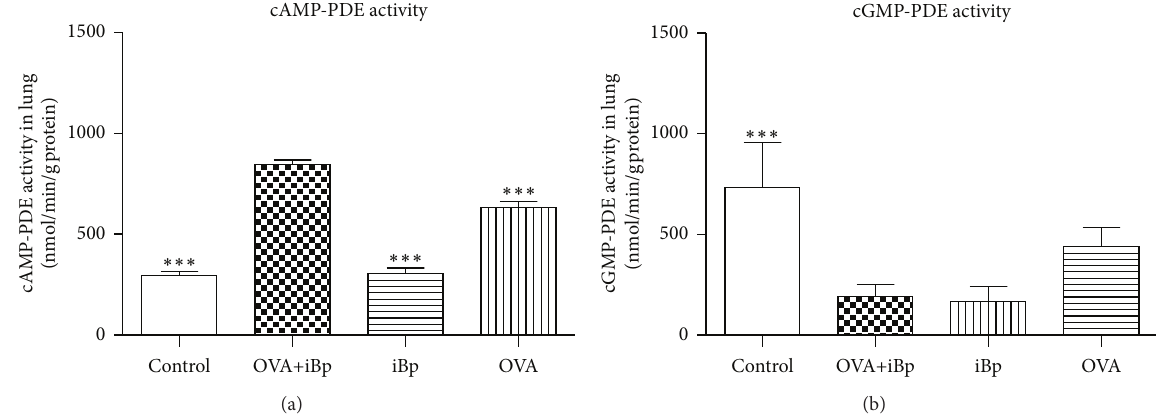
Figure 2: (a) Lung cAMP-PDE activity in normal ( 𝑛 = 8 ), OVA+iBp, iBp ( 𝑛 = 6 ), and OVA rats ( 𝑛 = 8 ); (b) lung cGMP-PDE activity in normal ( 𝑛 = 8 ), OVA+iBp, iBp ( 𝑛 = 6 ), and OVA rats ( 𝑛 = 8 ) (mean ± SEM; ∗ 𝑃 < 0.05 ; ∗∗ 𝑃 < 0.01 versus OVA+iBp; # 𝑃 < 0.05 ; ## 𝑃 < 0.01 versus